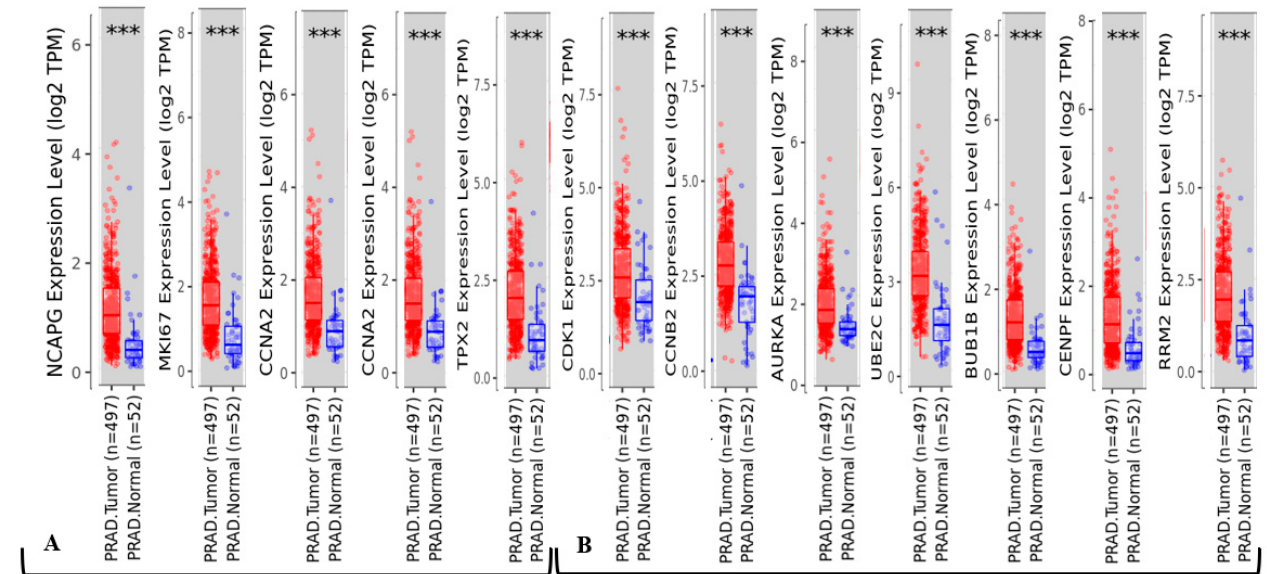
Figure 6. Differential analysis of expression of 12 hub genes between PCa (497) and normal prostate (52) tissues from Cancer Genome Atlas Prostate Adenocarcinoma (TCGA-PRAD) by TIMER: Tumor Immune Estimation Resource. ( A ): Query for 5 up-regulated hub genes. ( B ): Query for 7 down- regulated genes. ***: p -value < 0.001. TPM is transcripts per million with a normalization method for RNA-seq.